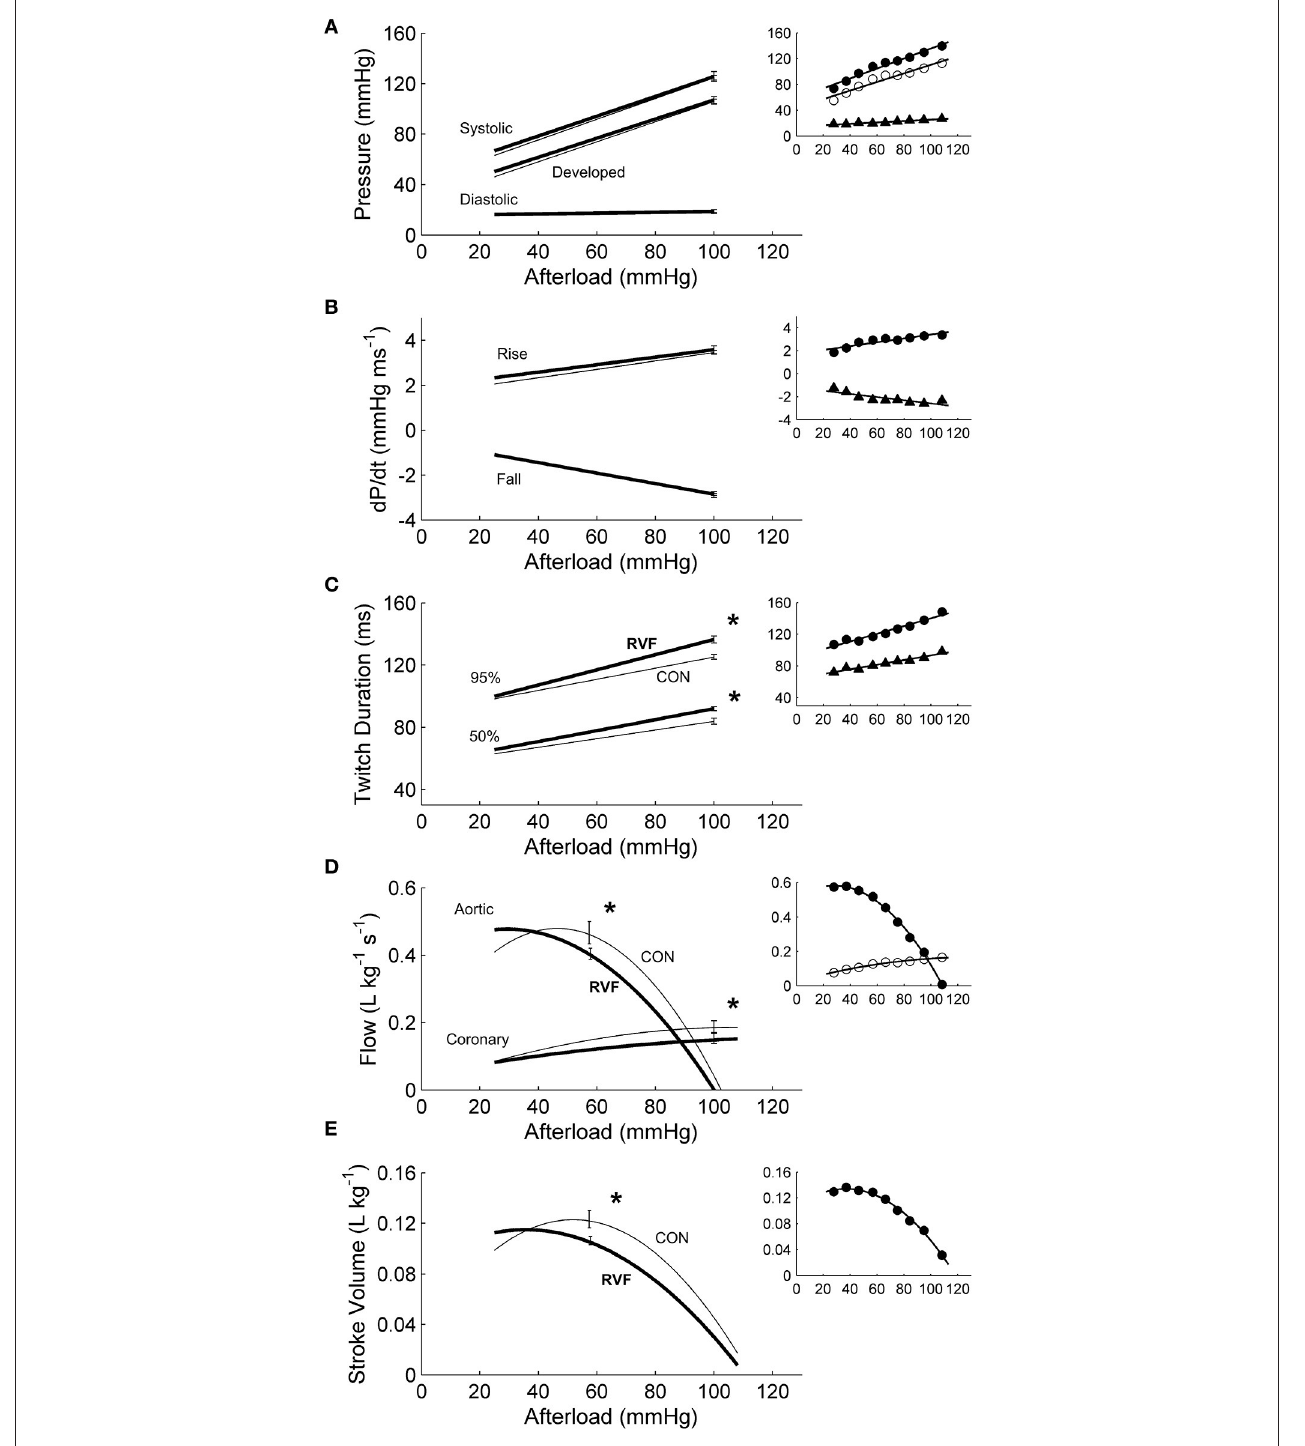
FIGURE 3 | Mechanics and hemodynamics of ex vivo left ventricles of hearts of control and right-ventricular failing rats. There were no statistically significant differences of the average regression lines between the control hearts (thin lines) and the RVF hearts (thick lines) in the pressures (A) or in the maximal rates (dP/dt) of rise and fall of twitch stress (B) . However, as indicated by the asterisks, RVF hearts had greater average twitch durations (C) , and reduced aortic and coronary flows (D) , as well as reduced stroke volumes (E) . Developed pressure is the difference between systolic and diastolic pressure. Twitch duration is quantified at 95% and 50% of peak systolic pressure. Stroke volume is the sum of aortic and coronary flow rates. All insets display representative data set obtained from a single representative heart.